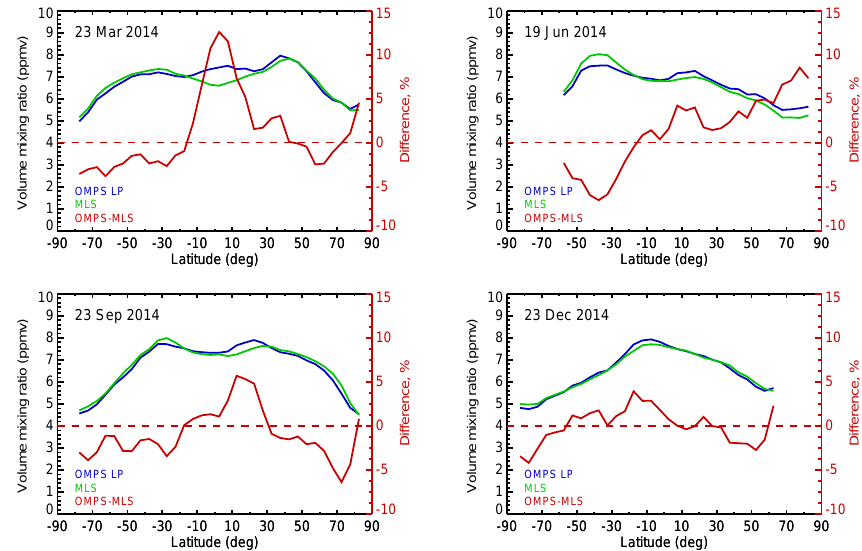
Figure 14. Daily 5 ◦ zonal means of ozone from MLS (green) and OMPS LP (blue), and the MLS–OMPS LP differences (red) at 3hPa GPH for 4 cardinal days. The latitudinal patterns of differences significantly vary with season but are within ± 10% over all seasons and latitude bands. If completely interpreted as due to TH error, a 10% difference would translate to less than 500m error.